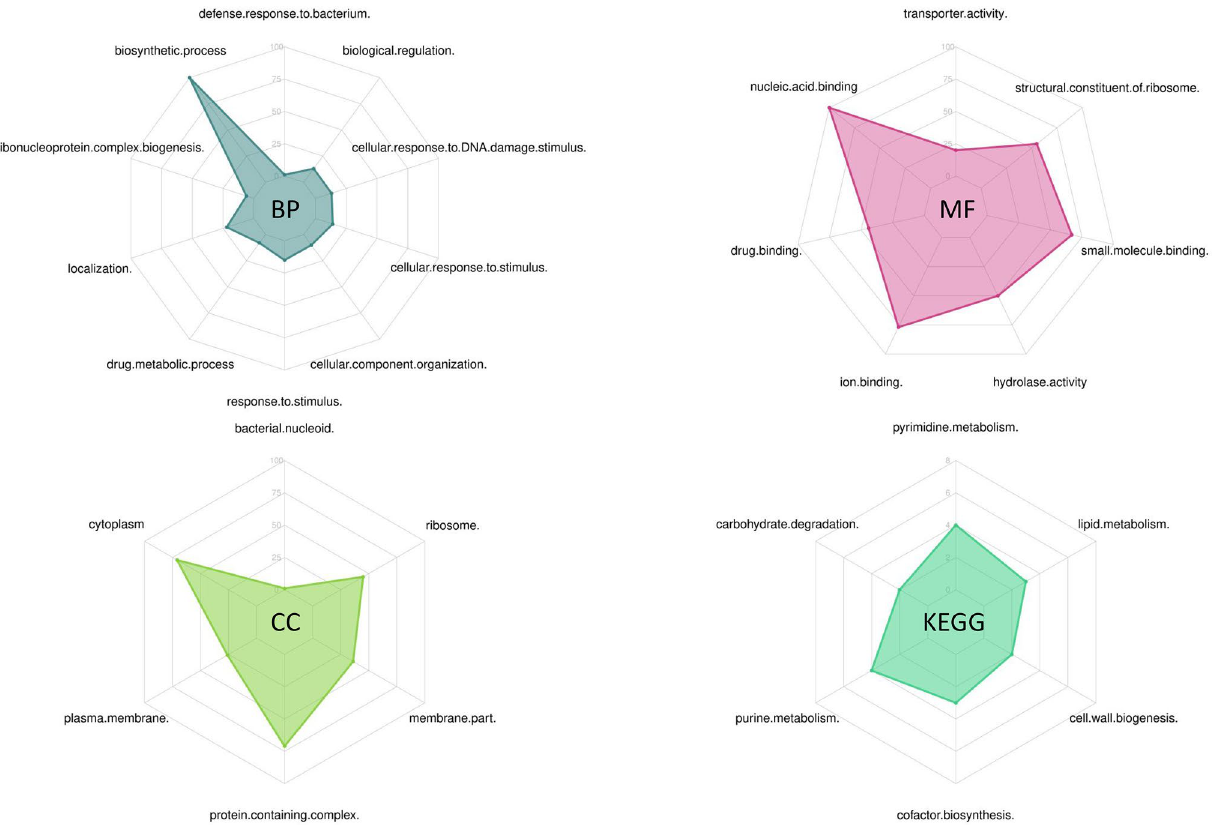
Figure 6. Gene Ontology (GO) analysis including the cellular component (CC), molecular function (MF), and biological process (BP) and KEGG pathway enrichment analysis of the genes encoding the 251 proteins present in the PPI. In each ontology, the enriched categories and the number of genes populating them are shown. Likewise, the enriched KEGG pathways and the number of genes in them are indicated. The GO was created using FMSB library (version 0.7.0—https:// cran.r- proje ct. org/ web/ packa ges/ fmsb/ index. html) in R 75